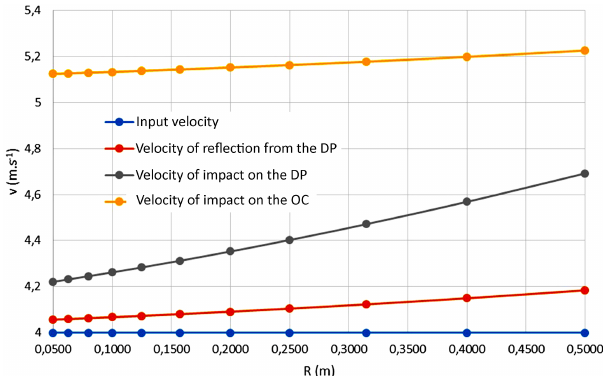
Figure 9. Graph of the velocity change for the material particle at v 1 = 4ms − 1